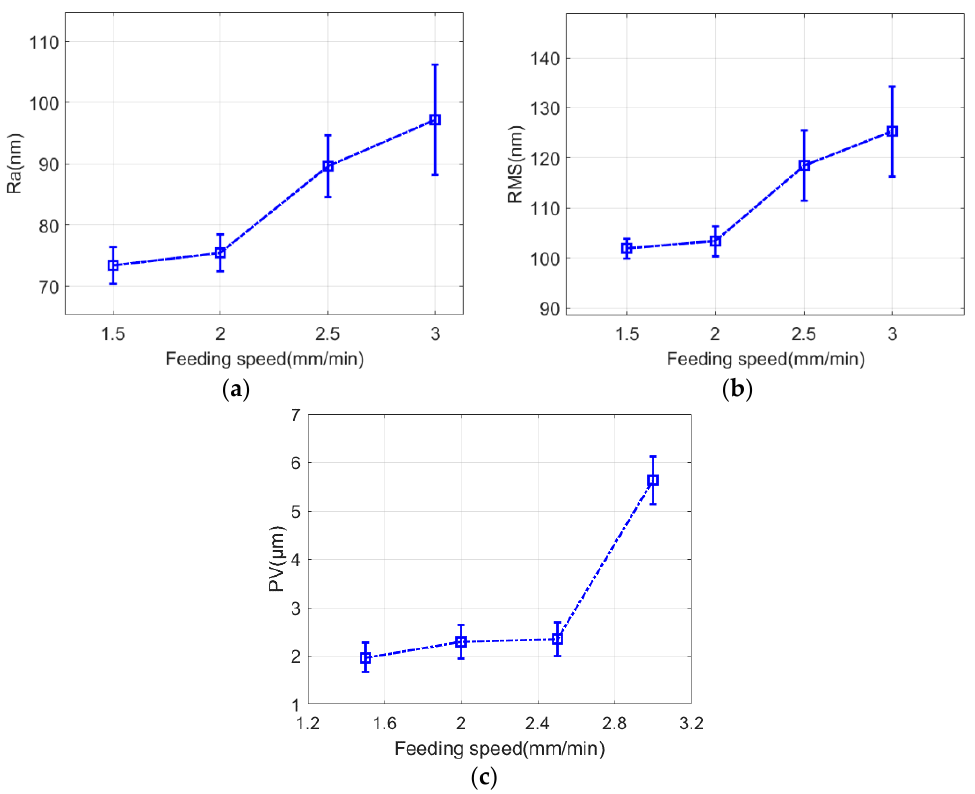
Figure 16. Effect of grinding marks on surface quality at different feed speeds. ( a ) Ra . ( b ) RMS . ( c ) PV.